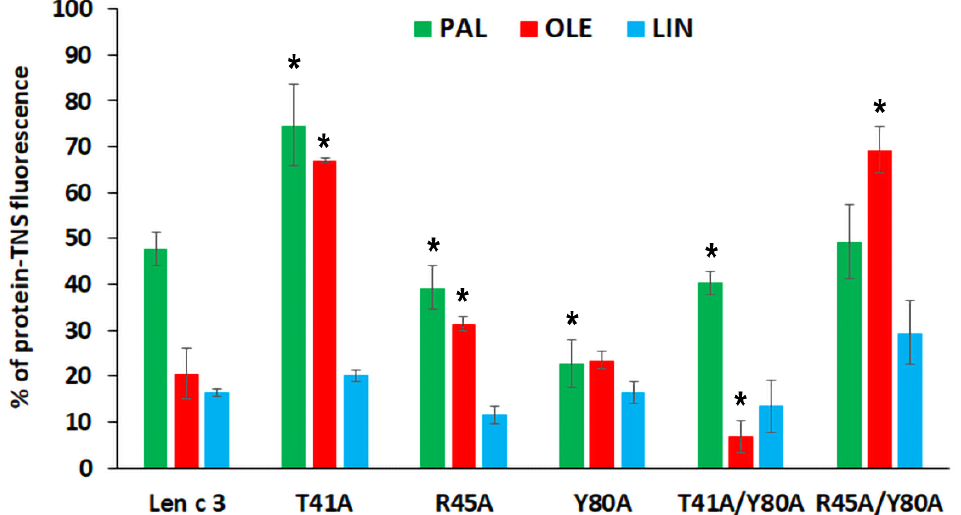
Figure 2. Effect of fatty acids on the fluorescence level of the protein-TNS complexes. The results are expressed as the mean values (±SD) of the percentage of the fluorescence using the protein-TNS complexes without ligands as controls. Differences in mean values between the percentage of the fluorescence of Len c 3 and its mutant analogues were estimated by Student’s t -test (significance level is: * p < 0.01).